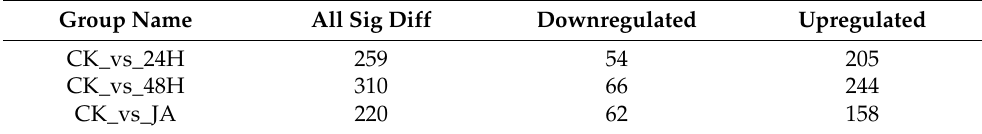
Table 4. Overlapping differentially expressed metabolites related to flavonoid biosynthesis and al- pha-linolenic acid metabolism detected in different groups.